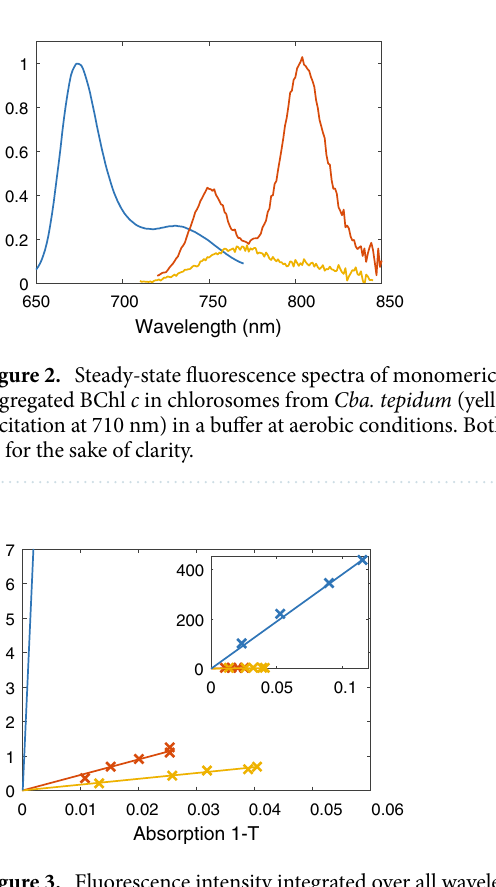
BChl c : β-Car Quant.